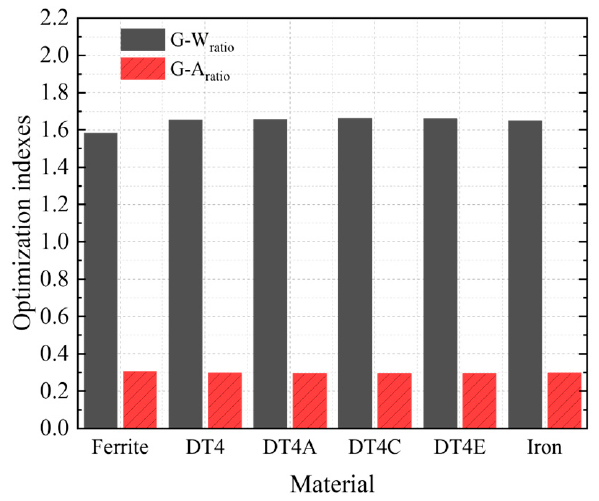
Figure 16. The variation in optimization indexes with different materials.